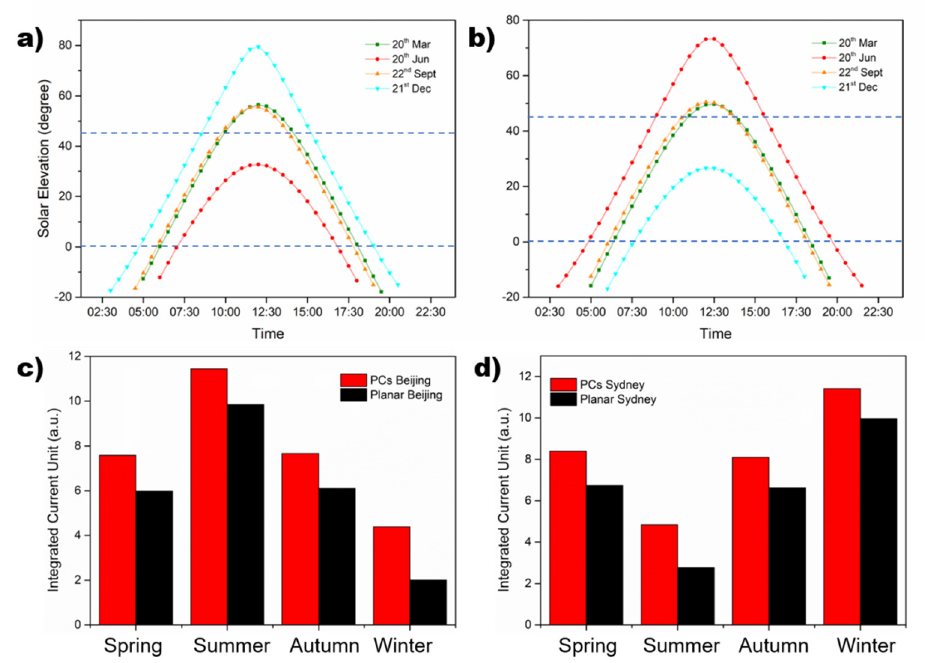
Figure 5. The solar elevations of ( a ) Sydney and ( b ) Beijing in the four seasons. The data were collected from NOAA Earth System Research Laboratories (ESRL); the overall photocurrent density generated in a day in ( c ) Beijing and ( d ) that generated in Sydney; the current density was normalized to get rid of the influence from the large surface area supplied by PC FTO.